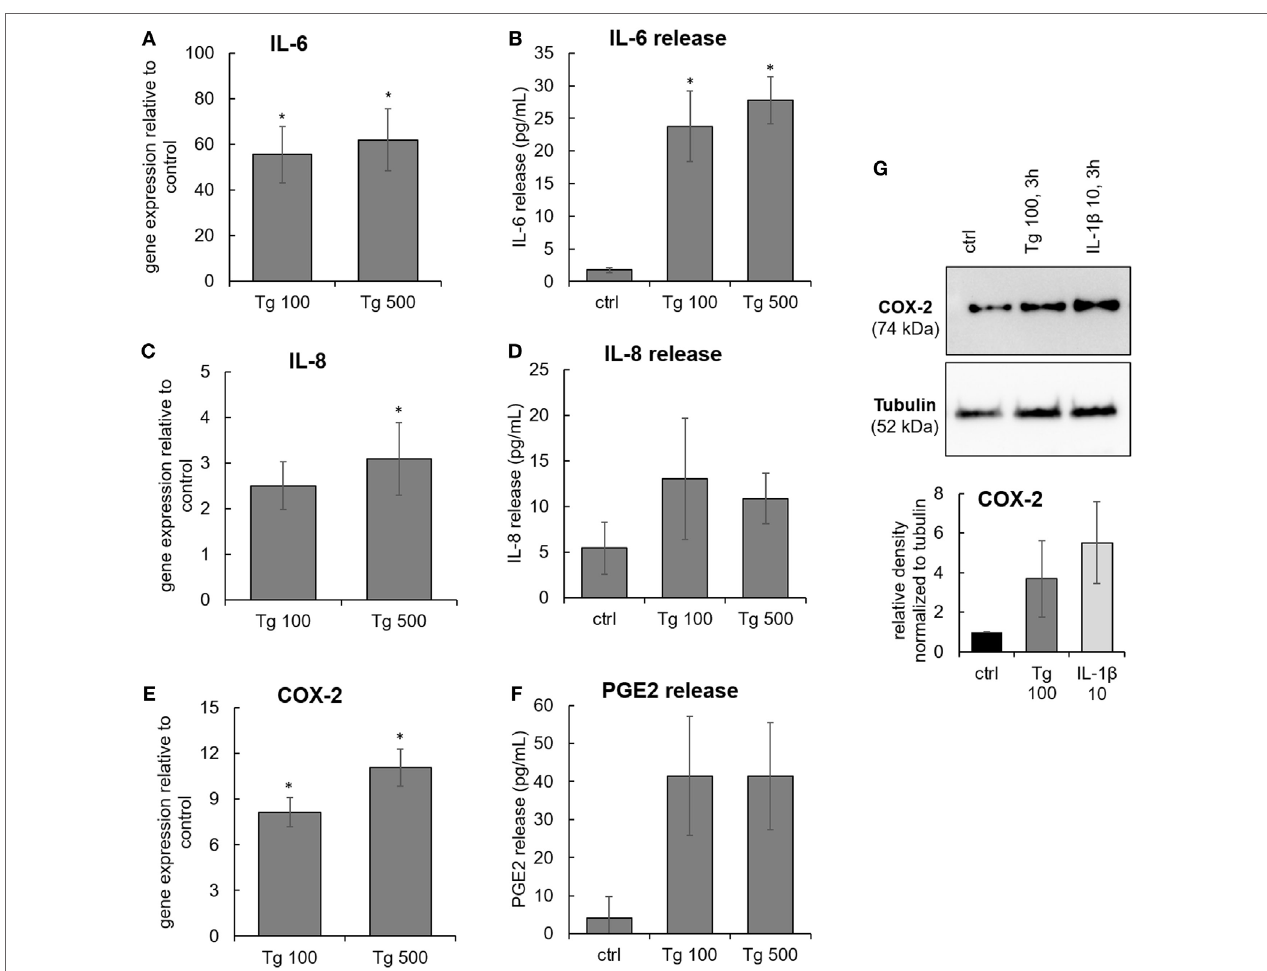
FigUre 3 | The expression of IL-6, IL-8, and COX-2 in endoplasmic reticulum stress. Cells were isolated from degenerated lumbar intervertebral discs (IVDs) and treated with 100 and 500 nM thapsigargin (Tg). (a,c,e) Treatment with Tg significantly induced gene expression of IL-6, IL-8, and COX-2 ( n = 7 donors, relative to control = set at 1) and (B,D,F) secretion of IL-6, but not IL-8 and PGE2 ( n = 7 donors). (g) Tg treatment elevated the protein expression of COX-2 ( n = 4 donors). IL-1 β (10 ng/mL) was used as positive control for immunoblotting. Data are presented as mean ± SEM, * p < 0.05 (ANOVA with Tukey post hoc